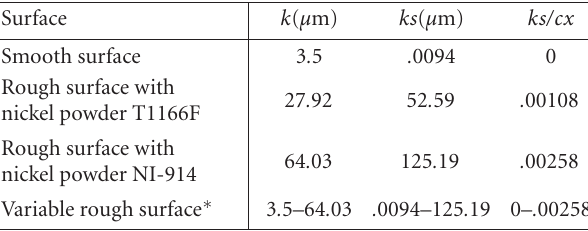
Table 4: Characteristics of rough surfaces